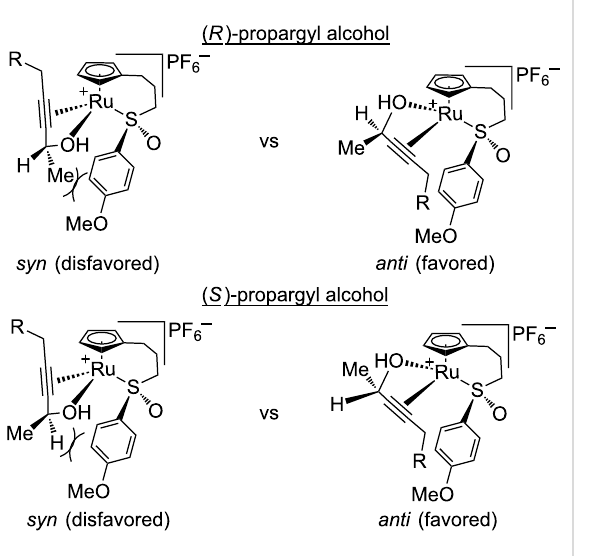
Figure 4: Diastereomeric metal complexes formed after alcohol coor- dination.